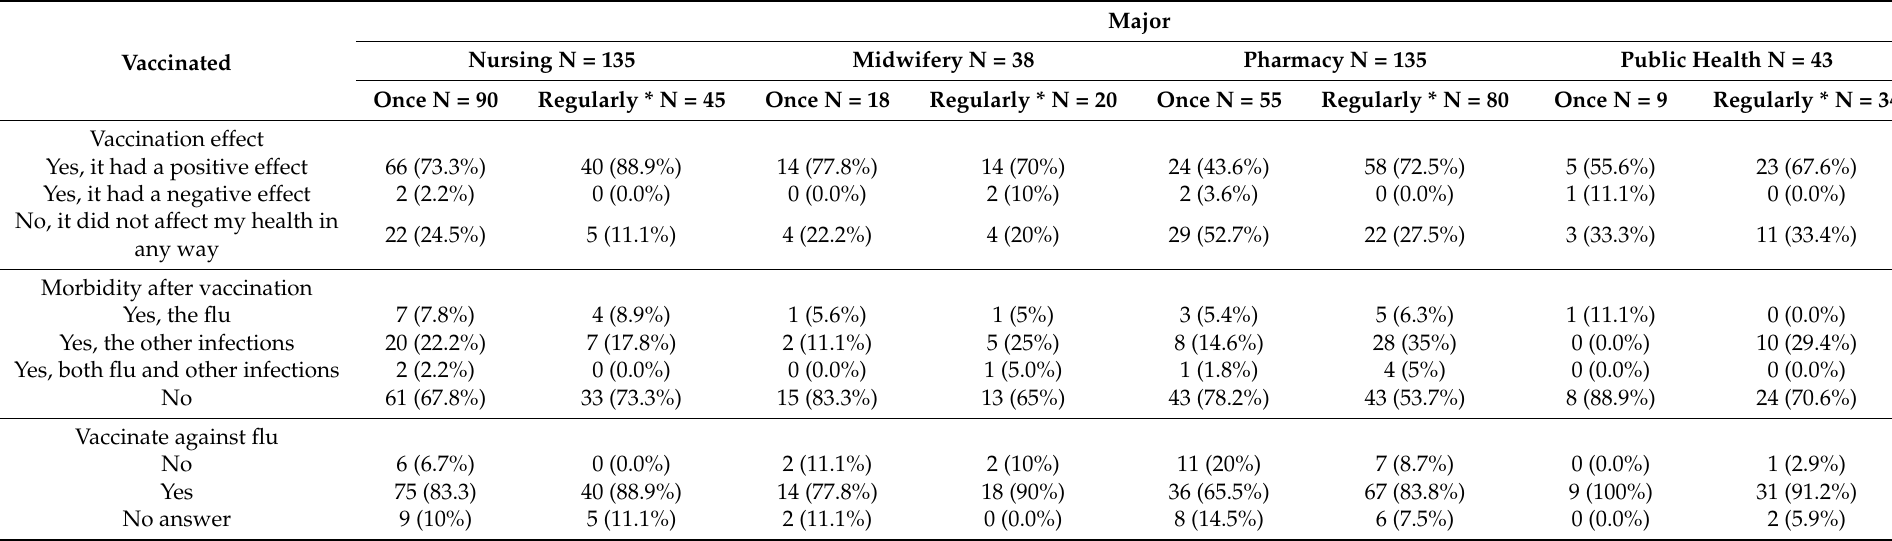
Table 1. Self-assessment of vaccine effectiveness among vaccinated students from four majors: Nursing, Midwifery, Pharmacy, and Public health.